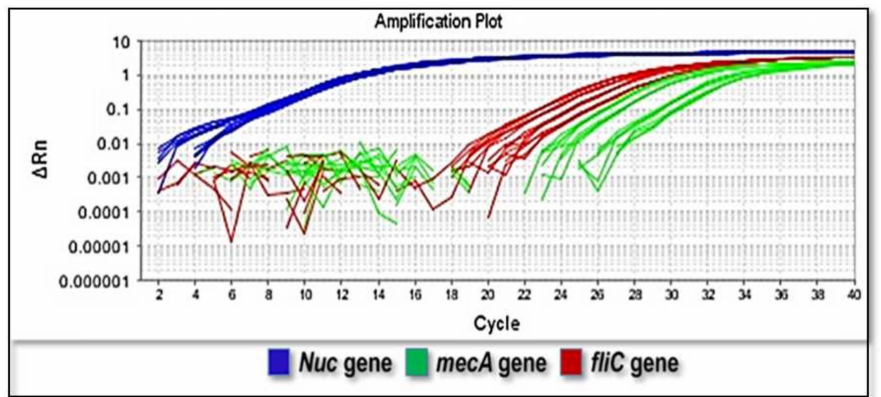
Figure 3. SYBR Green RT-PCR amplification plot for the identification of nuc (blue color) and mec A (green color) genes in Staphylococcus aureus and fli C gene (red color) in Escherichia coli strains. 3.5. Antimicrobial Resistance of Identified Staphylococcus aureus and Escherichia coli Strains MicroScan was applied to test the degree of S. aureus and E. coli resistance to numer- ous antibiotics frequently utilized for the management of both pathogens. As revealed in Table 3, all S. aureus strains (100%) were resistant to beta-lactam penicillins (ampicillin), beta- lactam/beta-lactam inhibitors (amoxicillin-clavulanic acid), first-generation cephalosporins (cephalothin) and quinolone (nalidixic acid) (Table 3). A total of 87.5%, 39.6%, 39.6%, 31.2%, 22.9% and 12.5% of S. aureus isolates were resistant to fourth-generation cephalosporins (cefepime), beta-lactam penicillins (piperacillin), second-generation cephalosporins (ce- foxitin), norfloxacin (fluoroquinolone), ciprofloxacin (fluoroquinolone) and tetracyclines (tetracycline), respectively. Table 3. Assessment of 14 antimicrobial agents against 48 Staphylococcus aureus and 43 Escherichia coli strains recovered from chilled ground meat